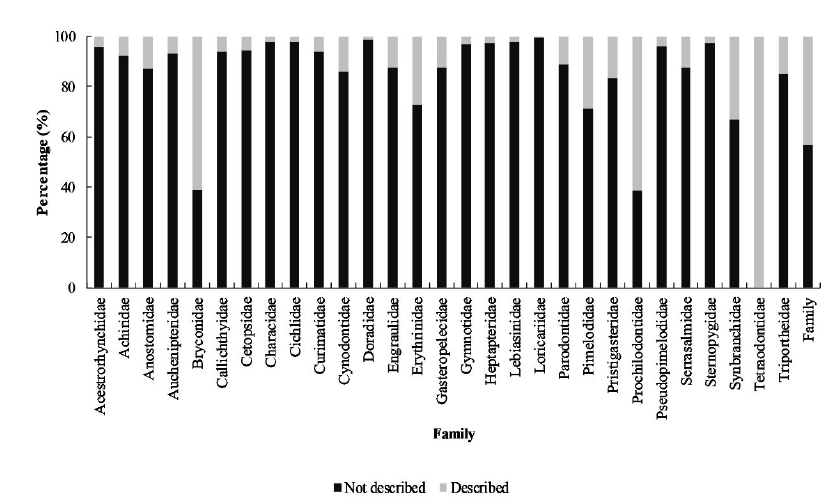
Figure 4. Fish families present in Brazilian continental waters and percentage of the number of species with early development described in the